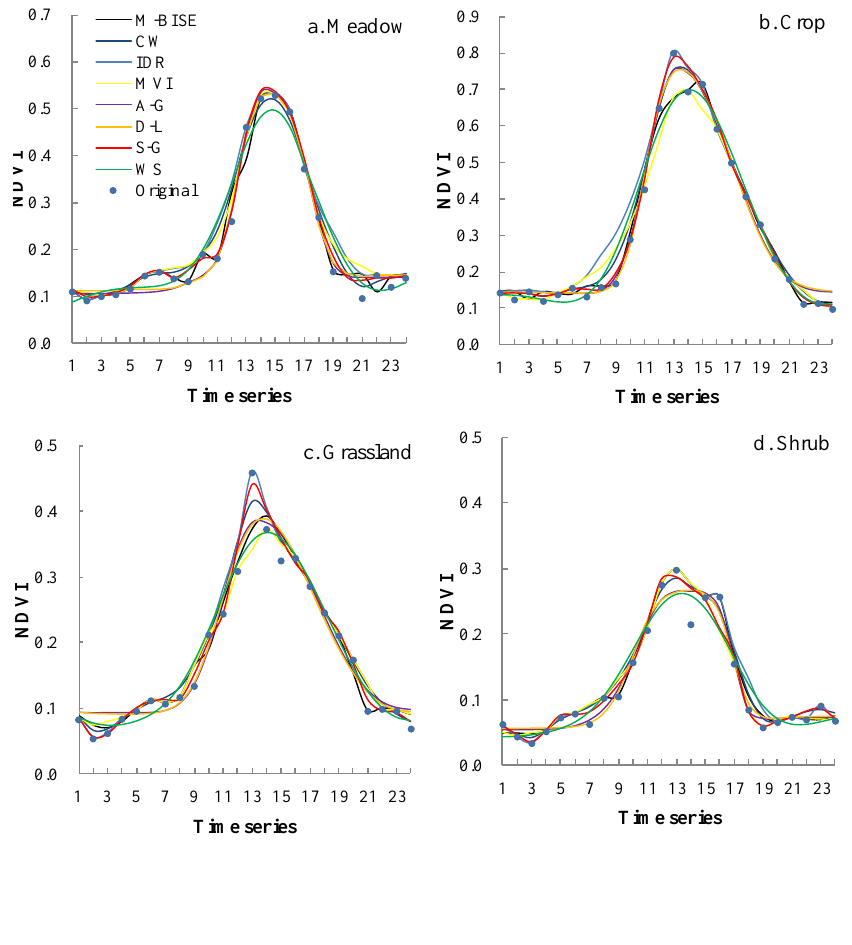
2. Eight techniques fitted to GIMMS NDVI time-series data acquired from homogeneous pixels of ( a ) meadow; ( b ) crop; ( c ) grassland; ( d ) shrub; and ( e ) desert vegetation.